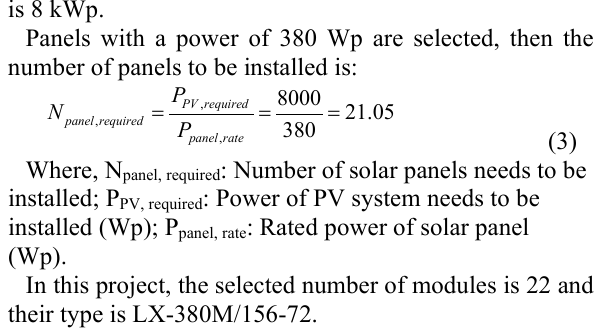
Table 1. Estimation of household's daily load